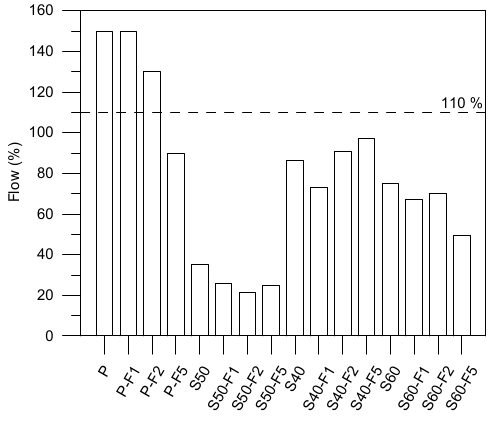
Figure 3. Flow test results.